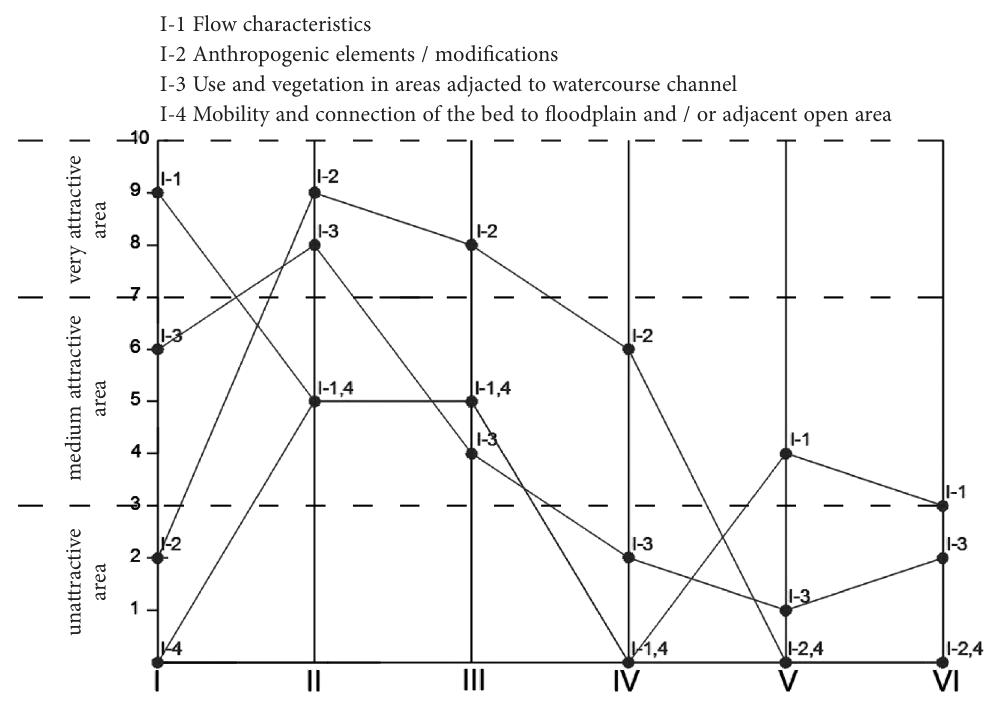
archives)Evaluated Figure 5. Values for integrated elements (I) in the LSHM Method assessment of the Skawinka river valley (drawing from the author’s private